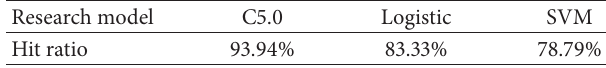
Table 2: Hit ratio of three models using the train